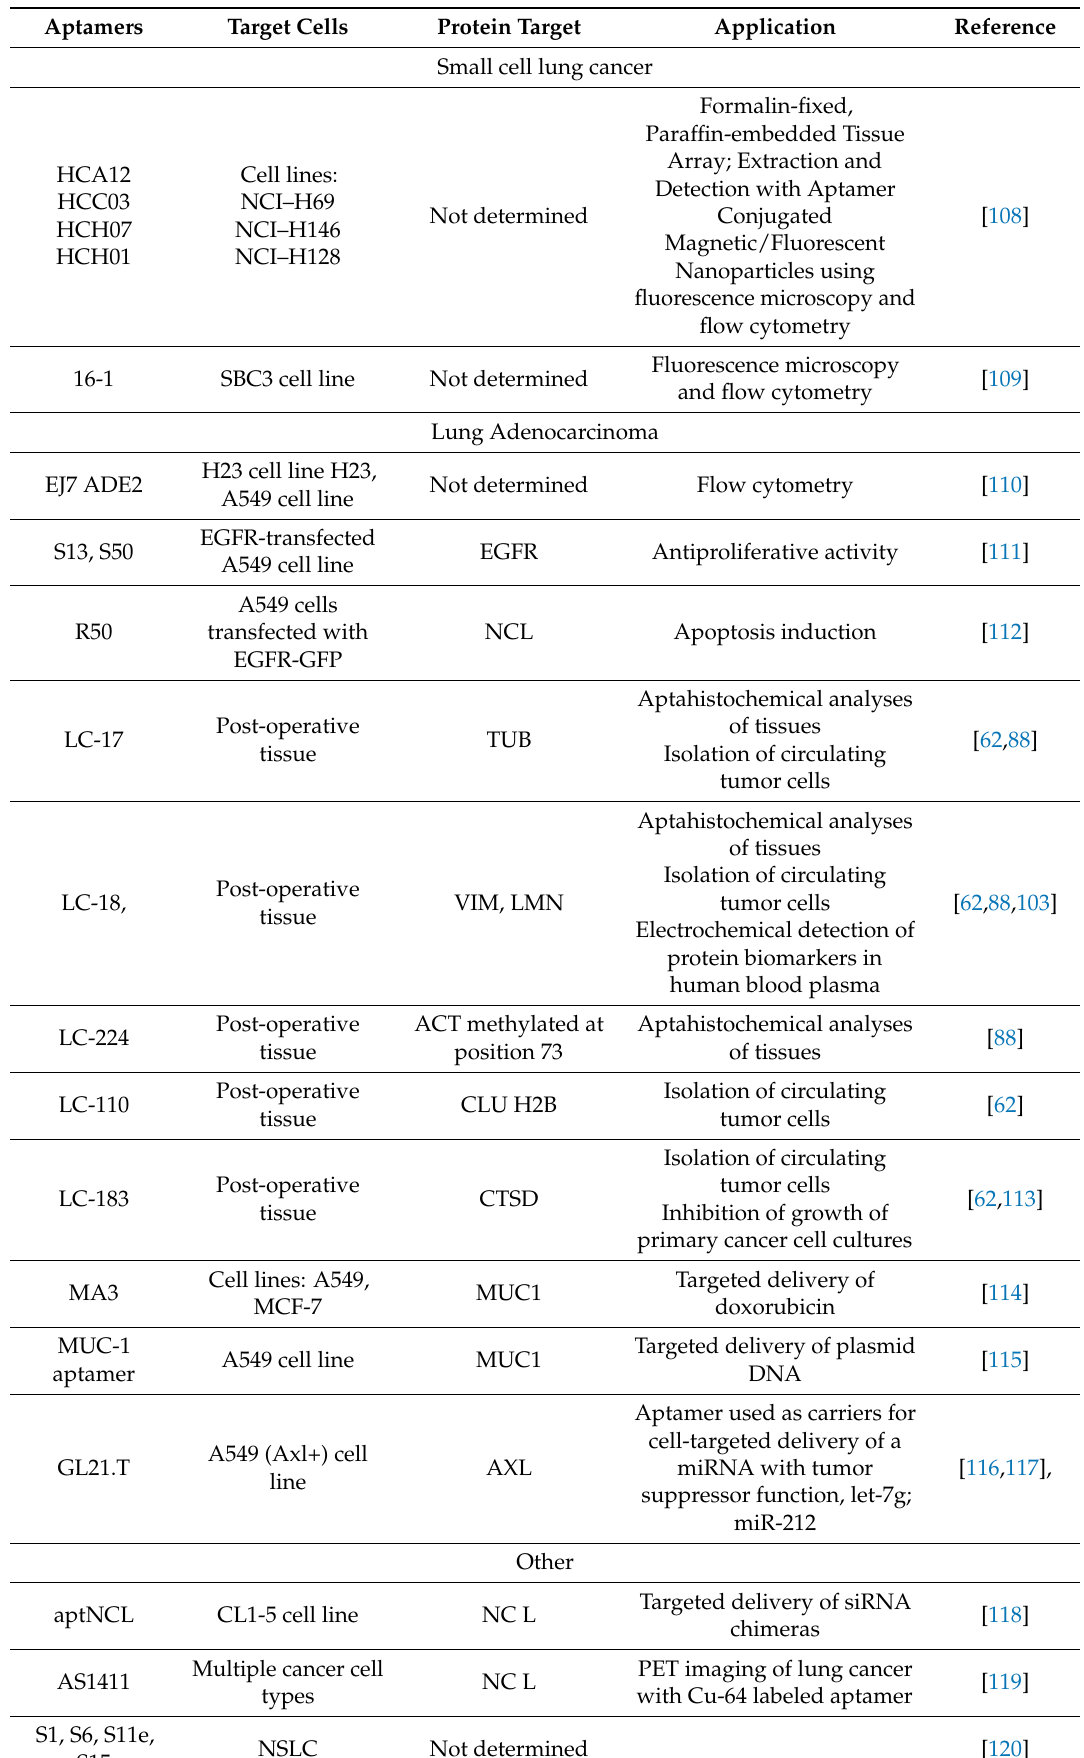
Table 3. Aptamers for lung cancer diagnostics and